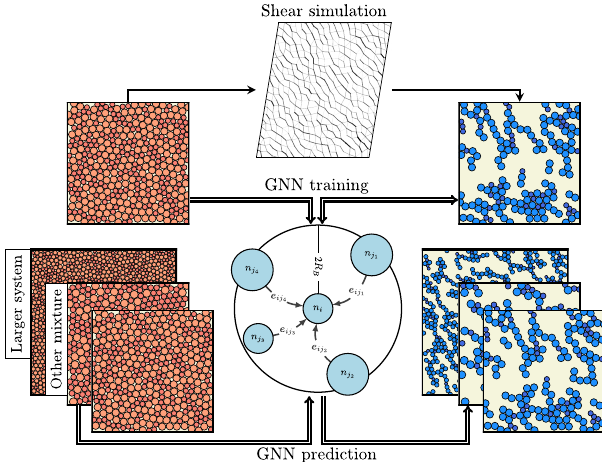
chains. We fi rst generate data on the formation of force chains via a traditional method, i.e., by shearing a model athermal solid in a simulation setup. We then train a graph neural network to predict the location of force chains in the deformed samples from the initial (undeformed) static structures. The trained graph neural network can then be used to predict the formation of force chains for other initial structures — even when e.g., the system size or particle mixture composition are very different from those used during